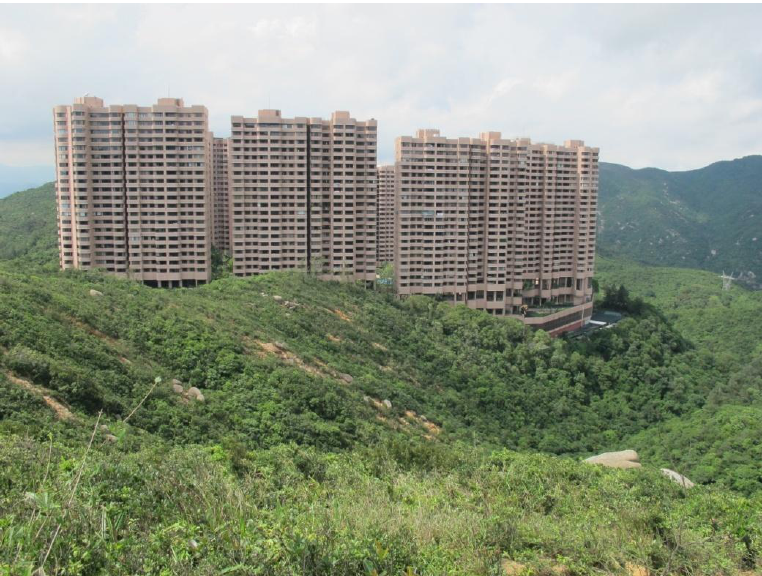
Figure 4. Parkview residential project (photo taken by PC Lai, May